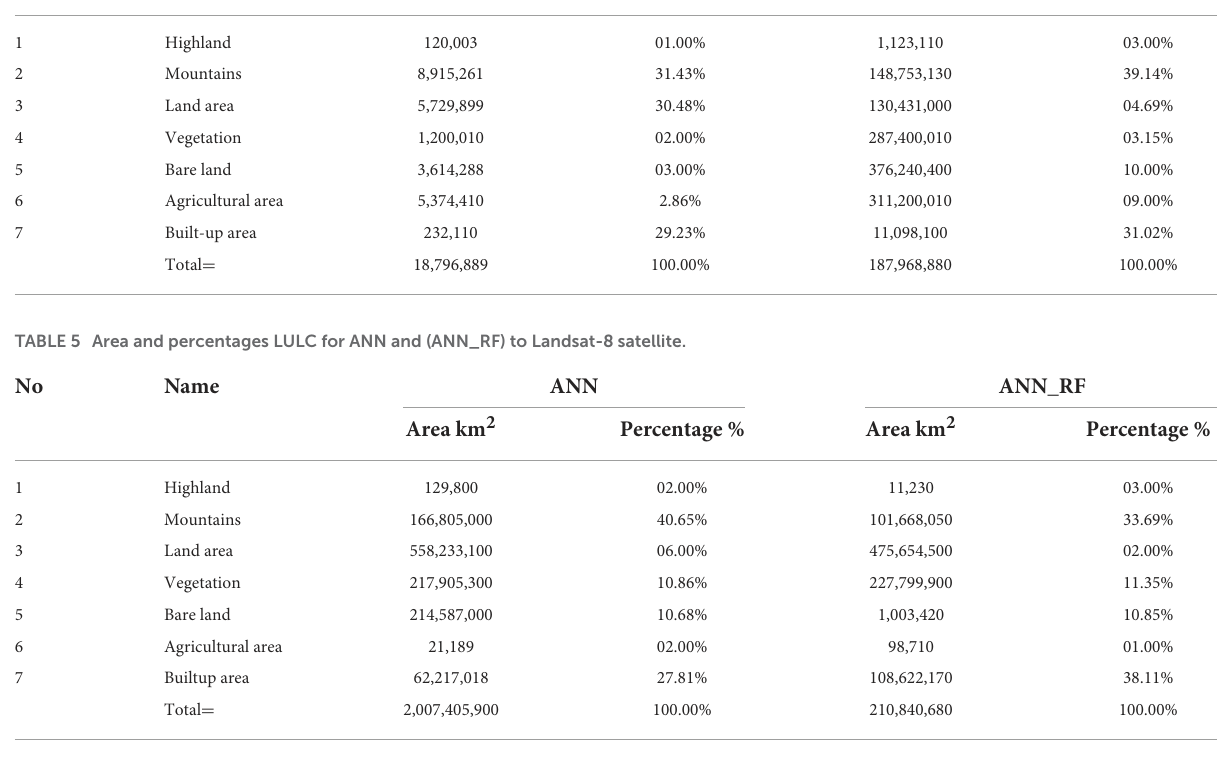
TABLE 6 Confusion matrix for ANN method of Sentinel-2A satellite